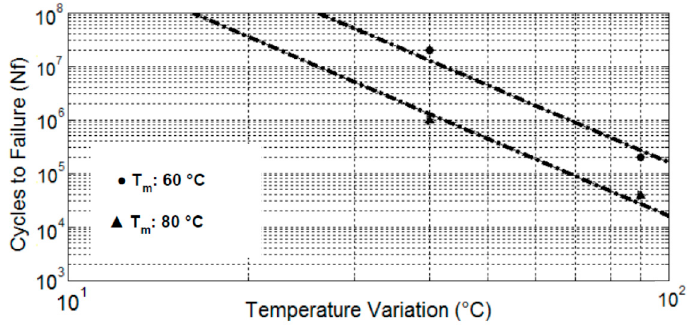
Figure 21. Lifetime curves. Figure 21. Lifetime